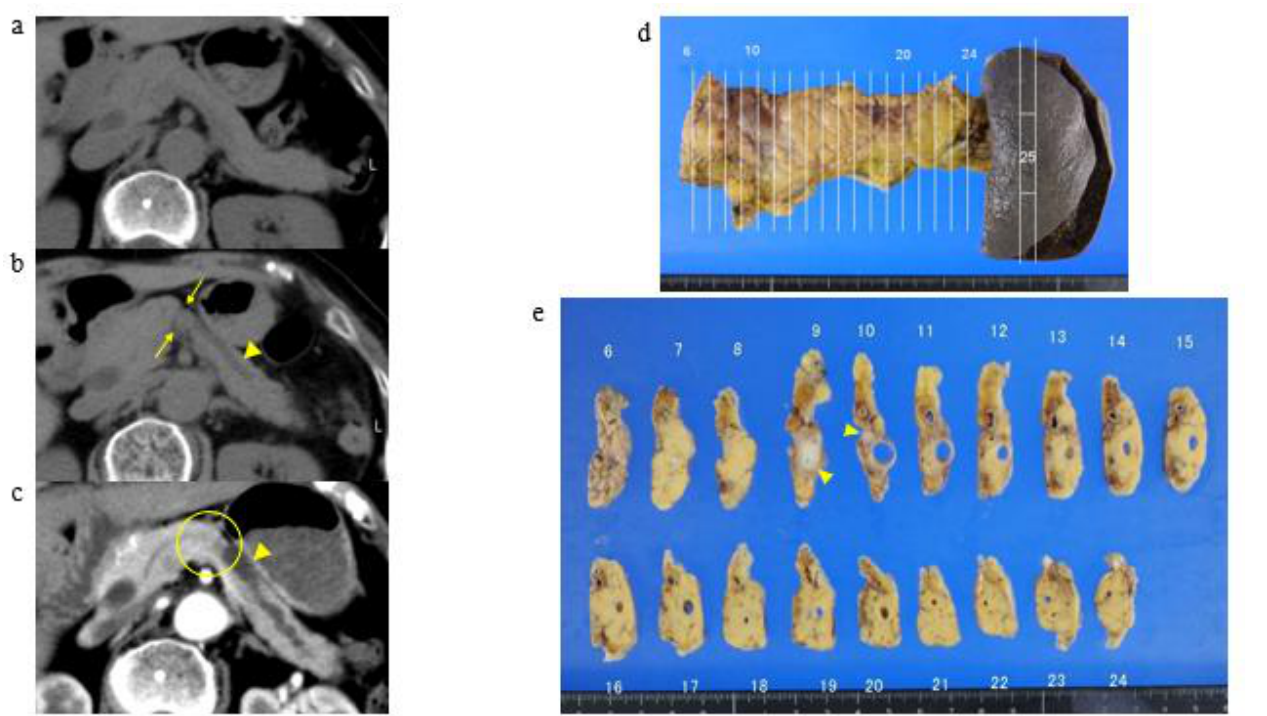
Figure 3. A representative case with K-sign (pStage IIB). ( a ) October 2008: pancreatic body shows no evidence of pancreatic abnormality. ( b ) June 2014: K-sign (yellow arrows) and the main pancreatic duct dilatation (an arrowhead) are shown in the pancreatic body. ( c ) August 2016: pancreatic body cancer with main pancreatic duct dilatation is shown in the K-sign area (a yellow circle and arrow head). ( d ) Pancreatosplenectomy was performed in September 2016. Macroscopic specimen did not show visible tumor invasion to the pancreatic surface and proof of K-sign. ( e ) The cross-section surface of the macroscopic specimen showed pancreatic cancer around the main pancreatic duct (yellow arrows). Table 2. Classification of CT